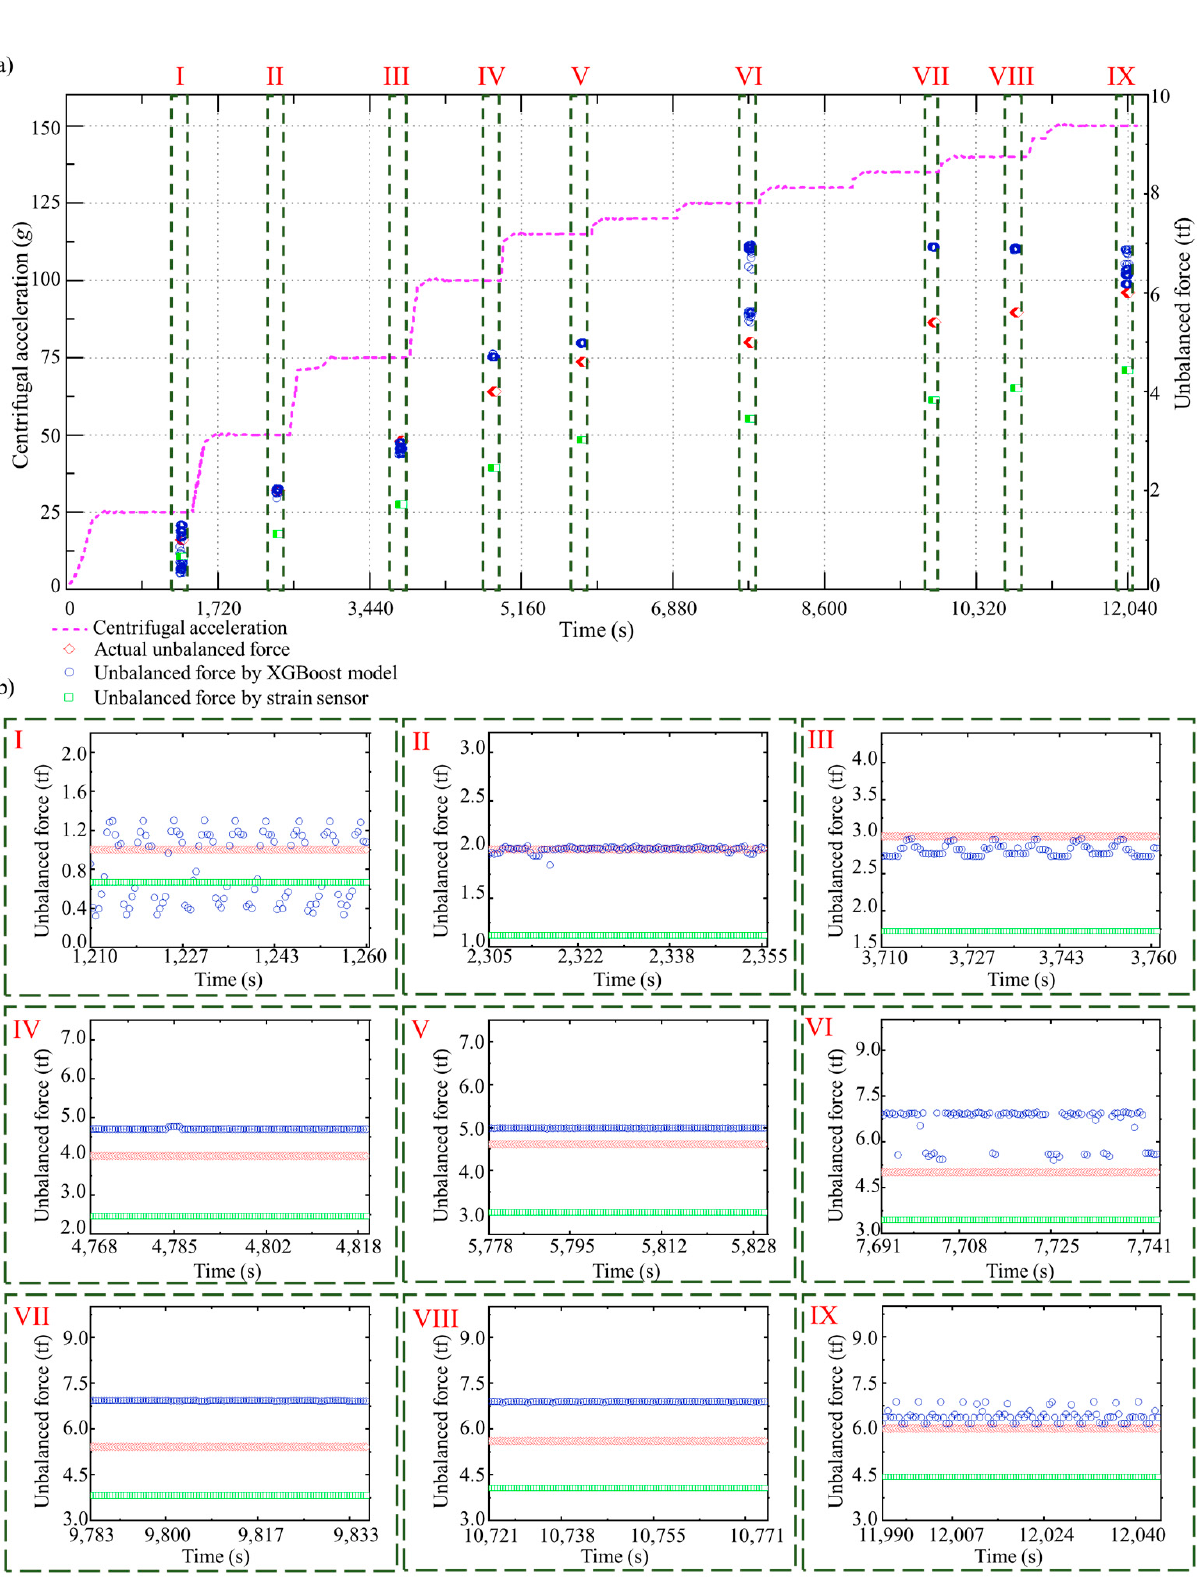
Figure 12. Unbalanced force identi fi cation results with the XGBoost model. ( a ) The whole speed-up process. ( b ) Identi fi cation results during each centrifugal acceleration step.